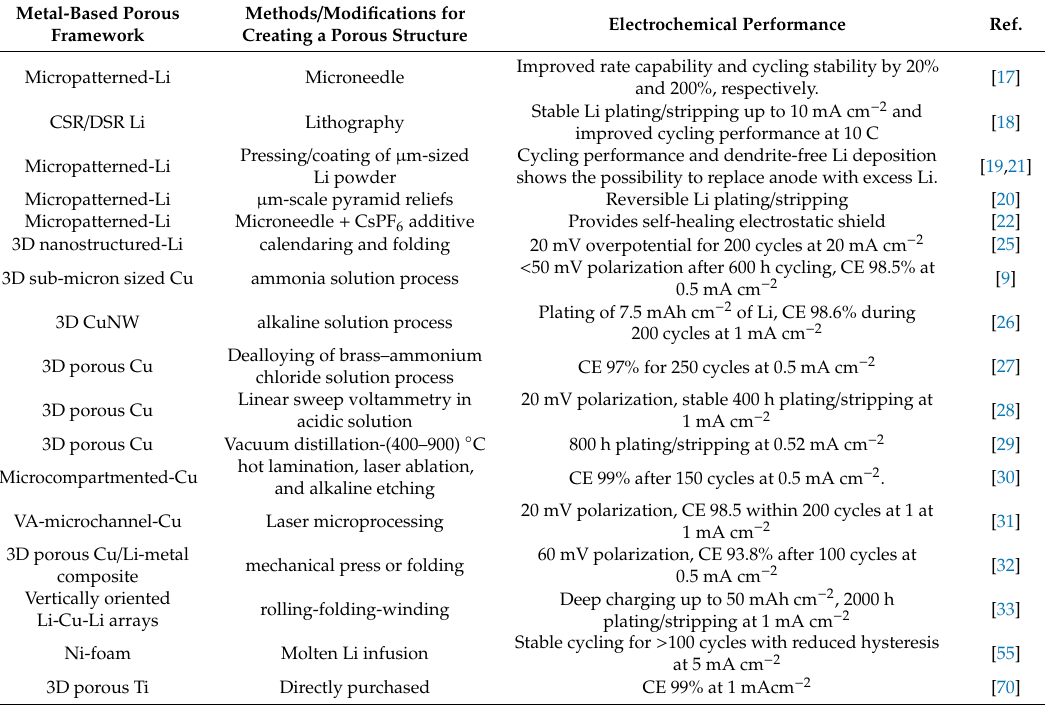
Table 1. Summary of the metal-based porous framework in lithium metal batteries